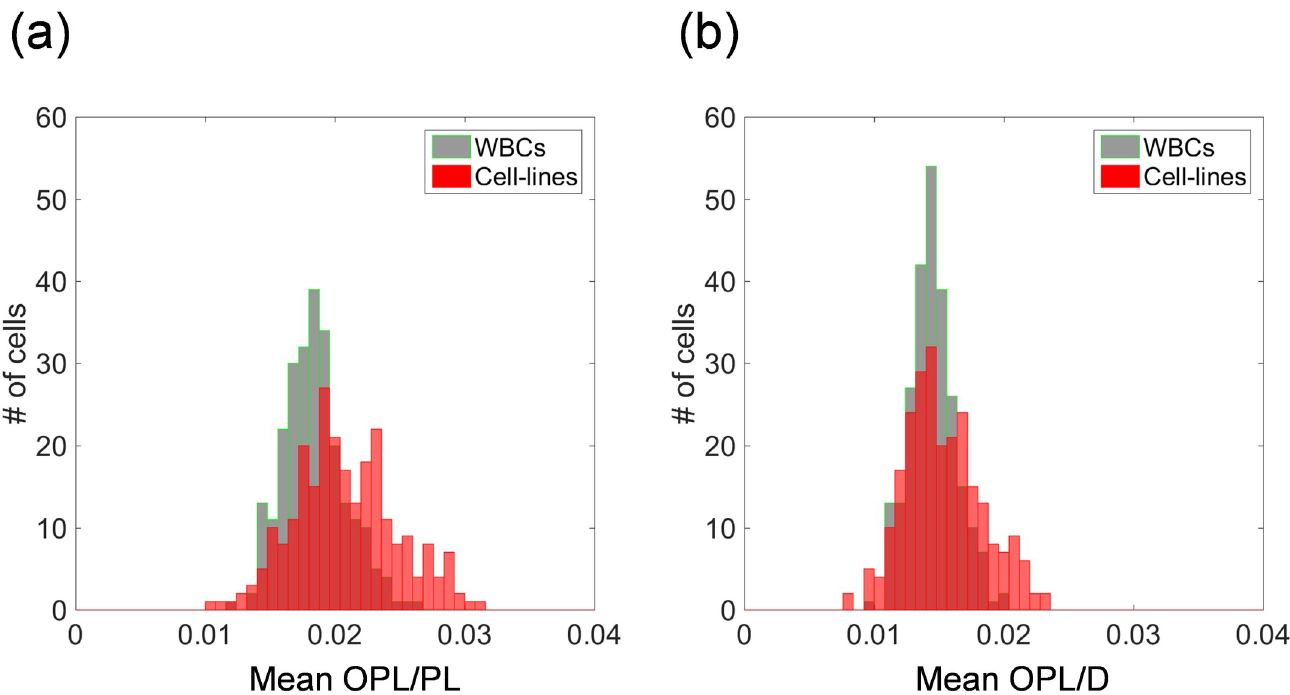
Fig 7. Statistical characteristics of two classes of training-data sets after two OPL normalizations. (a) Histograms of mean OPL normalized by path length (OPL/PL) over all WBCs and CLs and (b) histograms of mean OPL normalized by diameter (OPL/D) over all WBCs and CLs.